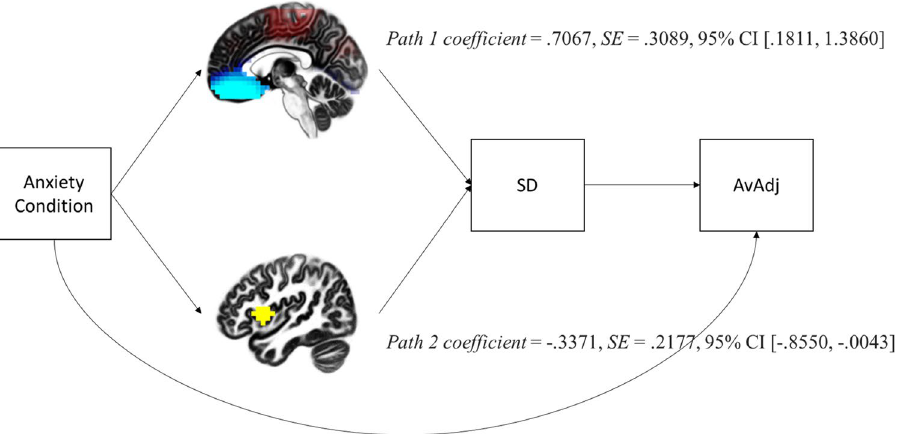
Figure 2. Bootstrapped parallel mediational model (PROCESS model 80; 5000 bootstrap samples for 95% confidence intervals). Path 1 is via delta band activation in the vmPFC (M1, peak voxel MNI coordinates = 5, 45, − 25). Path 2 is via right anterior insula activation (M2, peak voxel MNI coordinates = 45, 10, 5). Indirect effect coefficients confidence intervals for both paths do not contain zero, indicating the anxiety condition (i) causes decreased delta band activation in the vmPFC and this activation leads to decreased behavioral control and increased risk-taking, and (ii) causes increased right insula activation and this activation leads to increased behavioral control and reduced risk-taking.